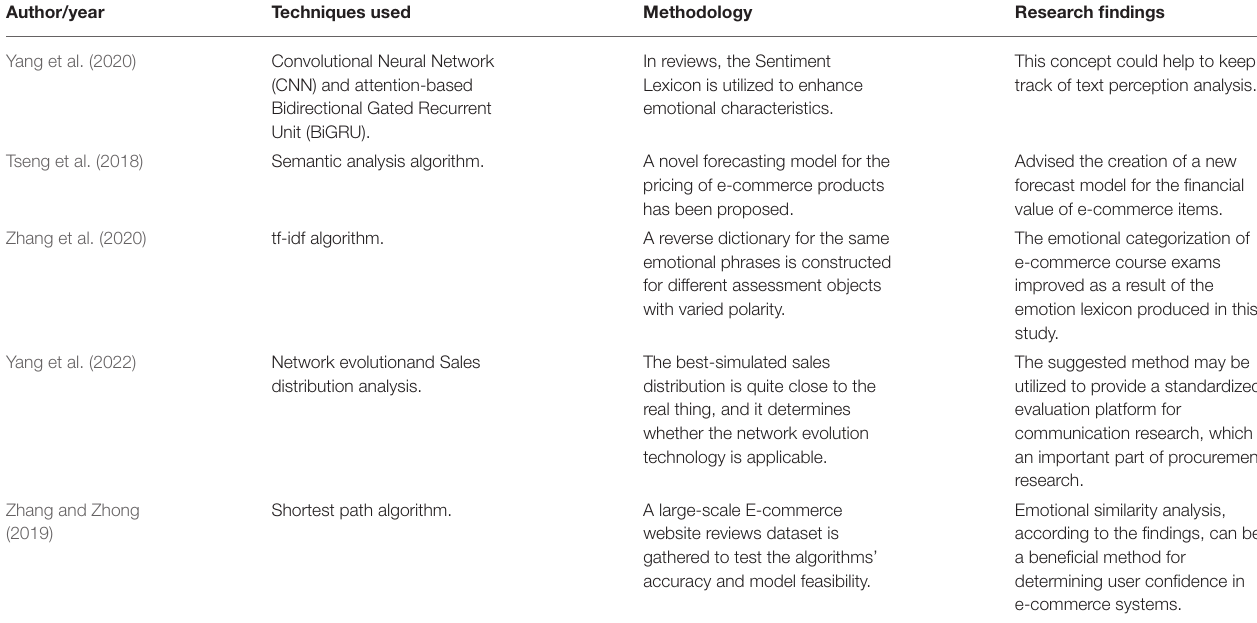
TABLE 1 | Literature